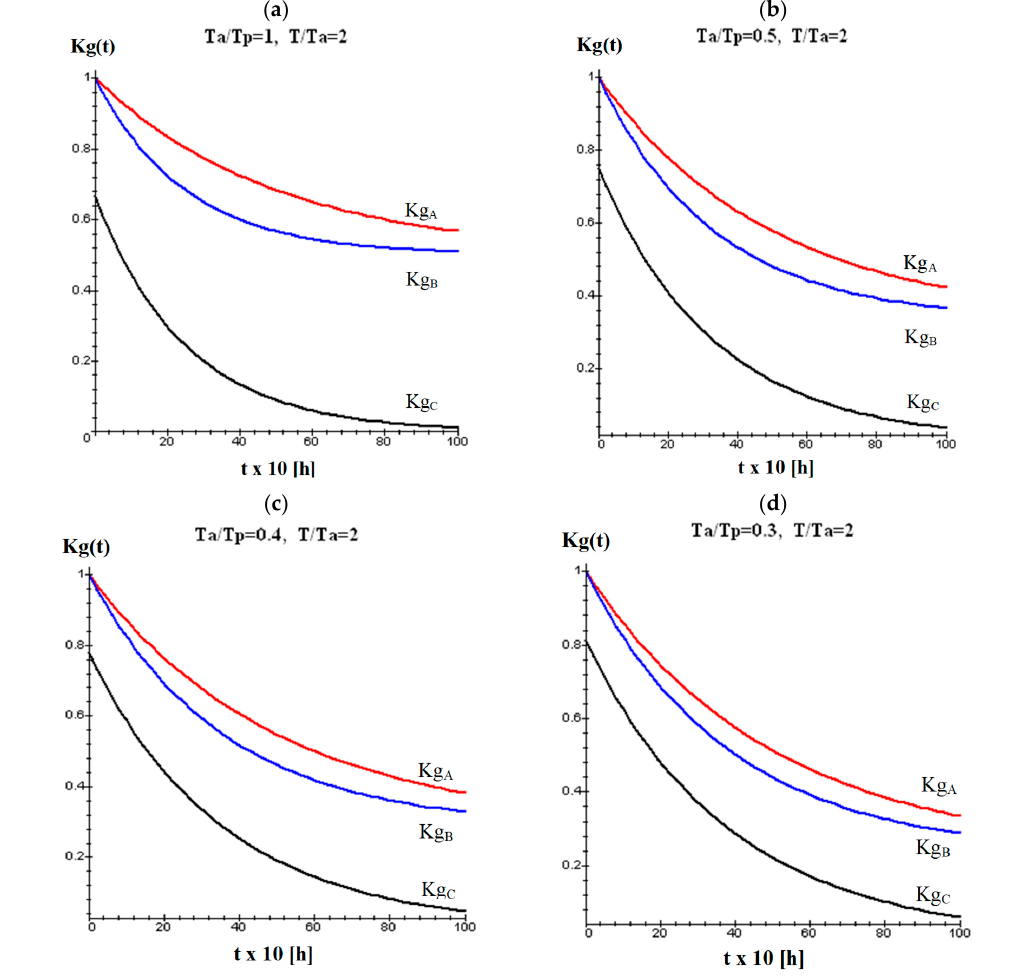
Figure 6. Courses of readiness function K g (t) in the operation process of wind power plant which uses various models of maintenance systems for condition T/T a = 2. various models of maintenance systems for condition T / T a = Symbol in the Figure 6. represent: